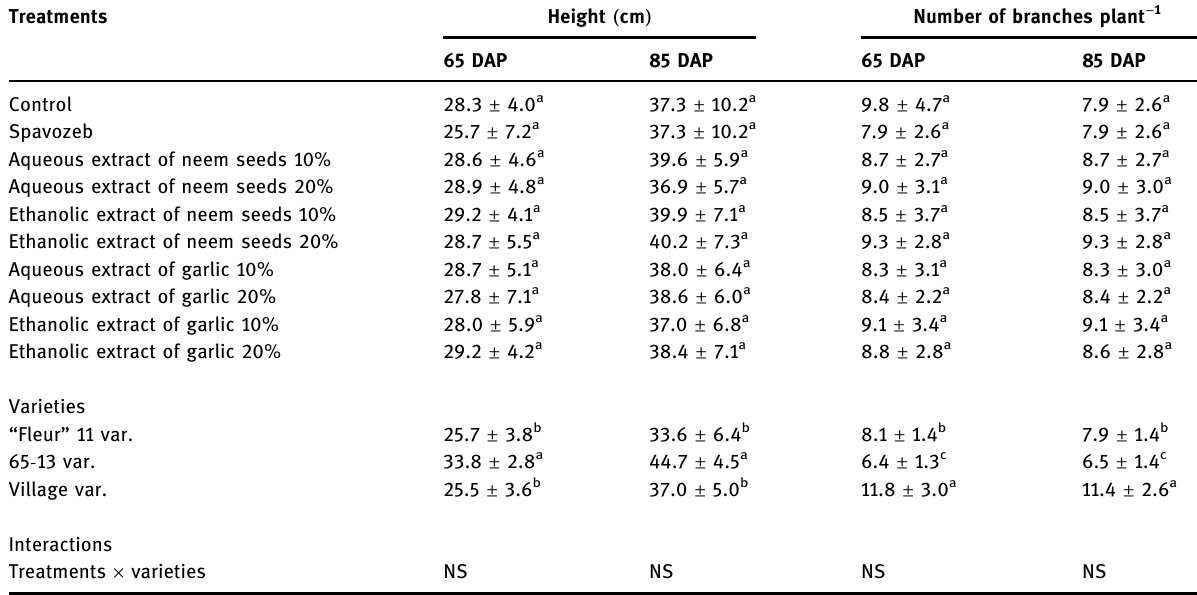
Table 5: E ff ect of phyto - extract application on the growth and development of groundnut